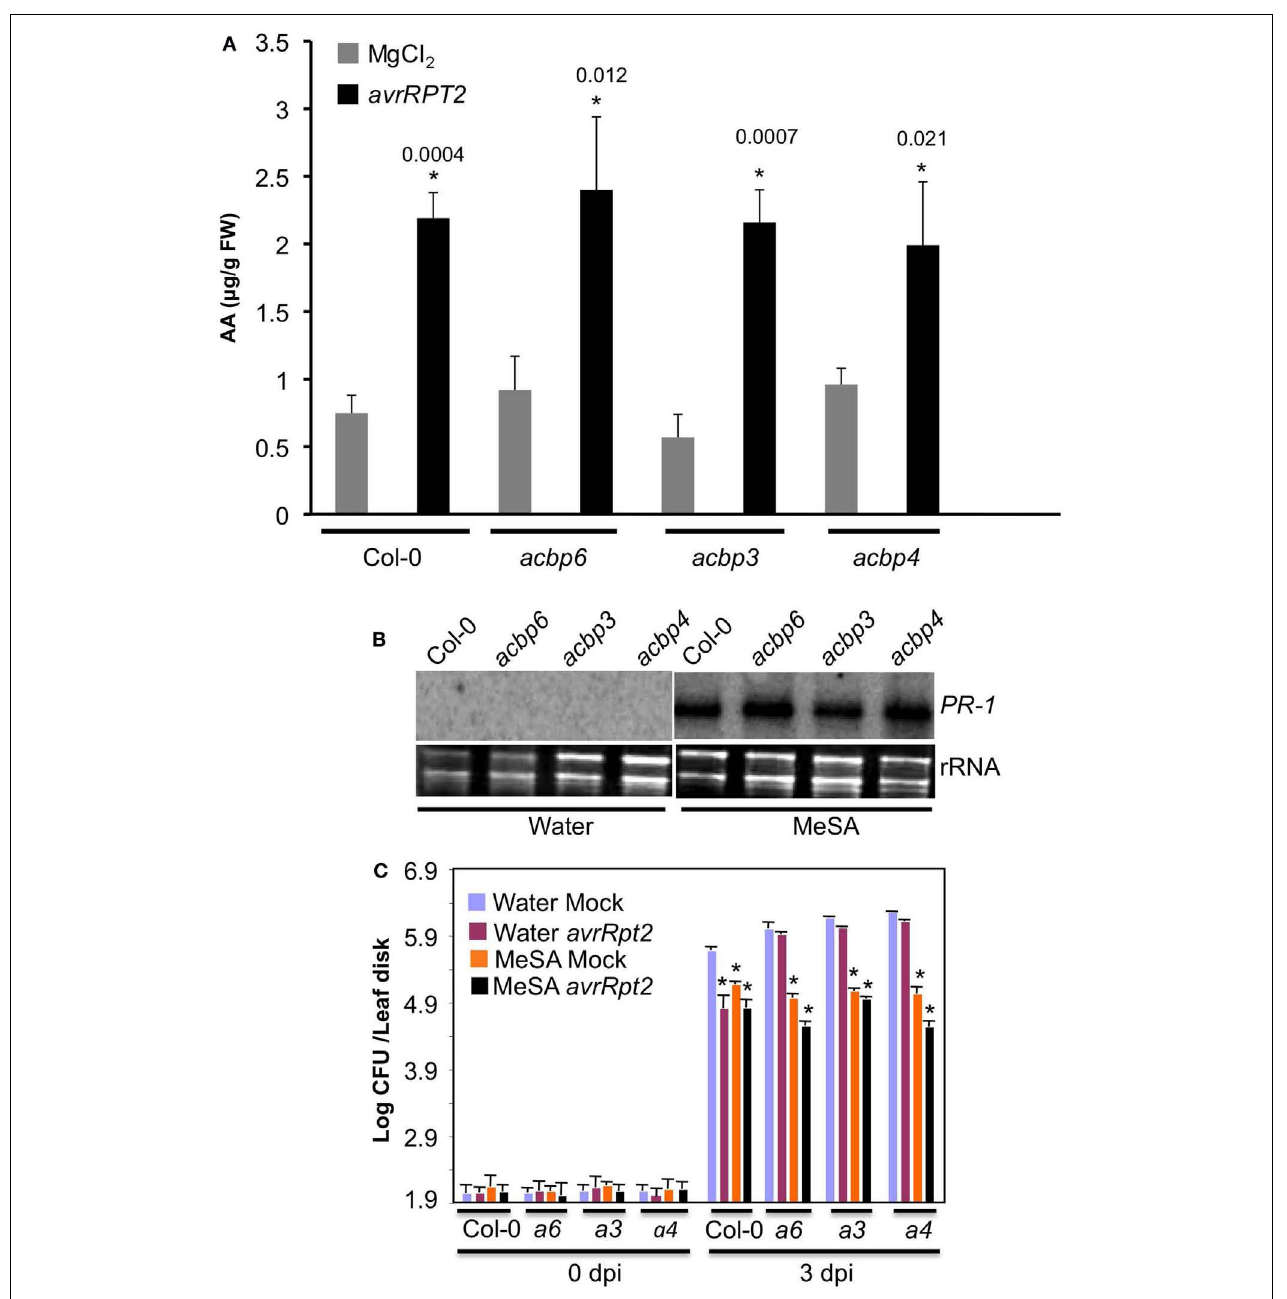
Ethidium bromide staining of total RNA was used as the loading control.The experiment was repeated twice with similar results. (C) SAR response in Col-0 and acbp6 ( a6 ), acbp3 ( a3 ), acbp4 ( a4 ) plants, pretreated with water (blue and pink bars) or 100 µ M MeSA (orange and black bars) prior to infiltration with MgCl 2 (mock, blue, and orange bars) or P. syringae expressing avrRpt2 (pink and black bars). Bacterial growth presented as the LOG of colony forming units (CFU) per leaf disk, was monitored at 0 and 3dpi. Error bars indicate SD ( n = 4). Statistical significance was calculated using Student’s t -test ( P <